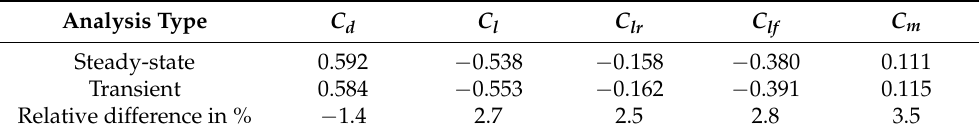
Table 4. Comparison of forces and moments obtained in steady-state and transient